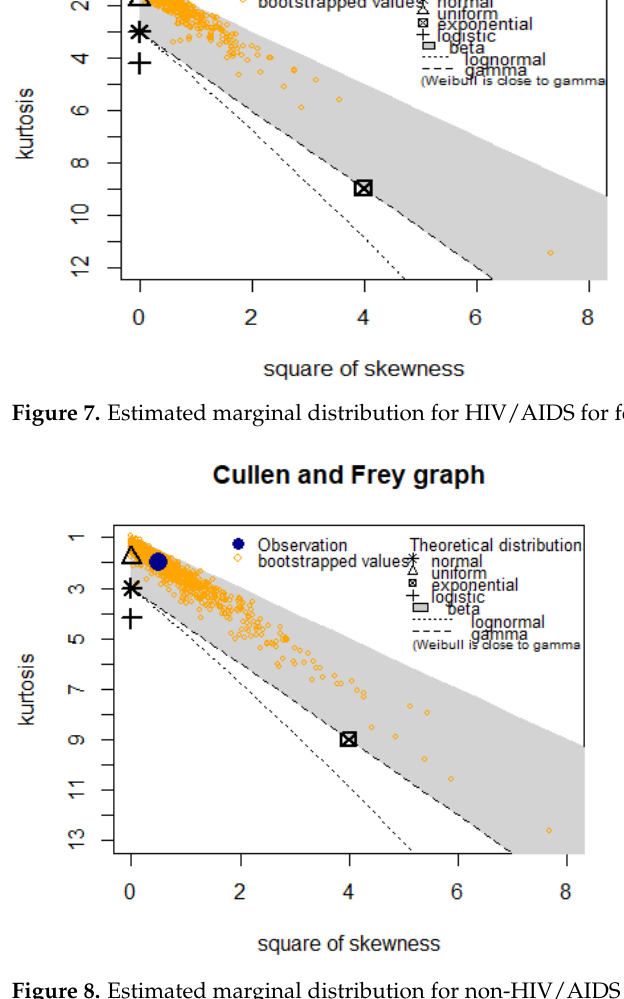
Figure 8. Estimated marginal distribution for non-HIV/AIDS for males.